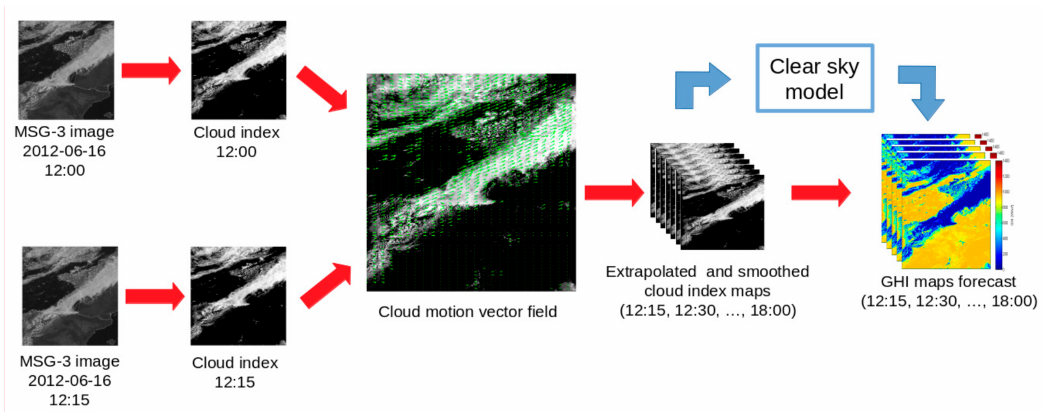
Figure 2. Schematic representation of satellite-based forecast principles (example taken from [38]). GHI: global horizontal irradiance; MSG: Meteosat Second